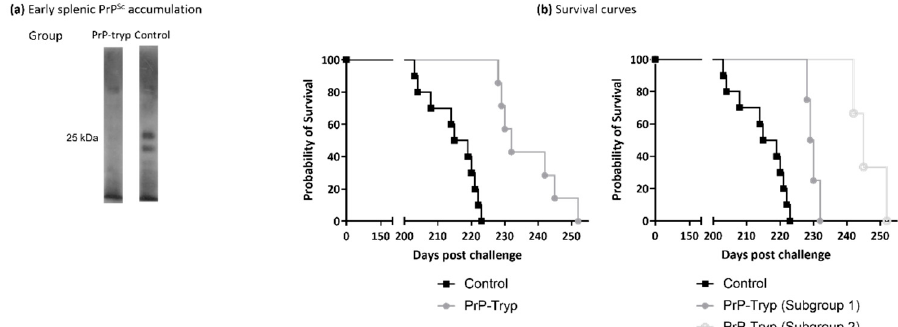
Figure 4. Immunization provides partial protection in the murine animal model. ( a ) Representative Western blotting of splenic homogenates enriched in PrP Sc from PrP-tryp immunized and control mice, using 6H4. PrP-tryp immunized mice accumulate less splenic PrP Sc at the early stages of disease (a total of four PrP-tryp immunized and four control immunized mice were sacrificed at early timepoints). ( b ) Survival curves indicate that PrP-tryp-immunized (N = 7) mice survive significantly longer than control (N = 11) mice (left panel, Log-rank (Mantel-Cox) test, p < 0.0001). Immunization seems to result in different levels of protection, as two distinct subgroups with different survival curves (Log-rank (Mantel-Cox) test, p = 0.0177) can be identified (right panel).